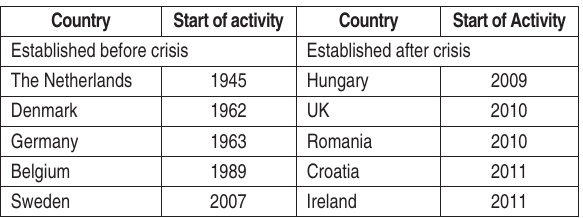
Table 5. Overview of fiscal council established before and after